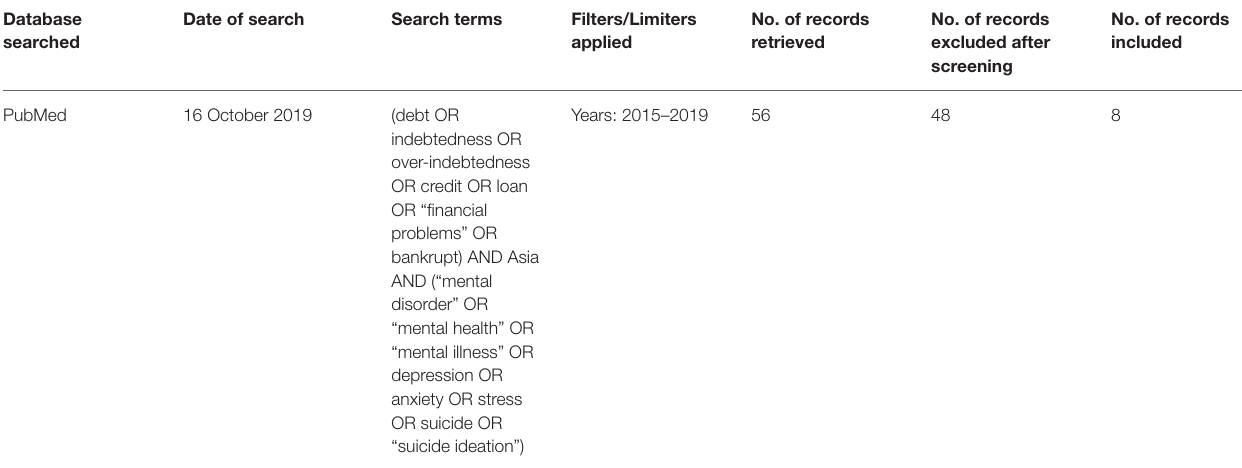
TABLE 6 | PubMed Search